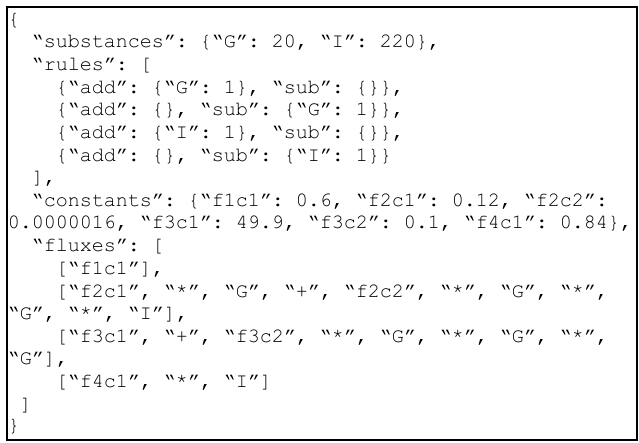
Fig. 4. MP grammar of IVGTT encoded in JSON data